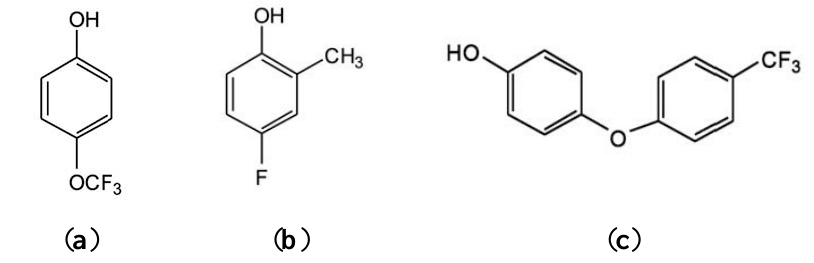
Figure 1 . Structures of the fluorophenols used in the coupling reactions: ( a )